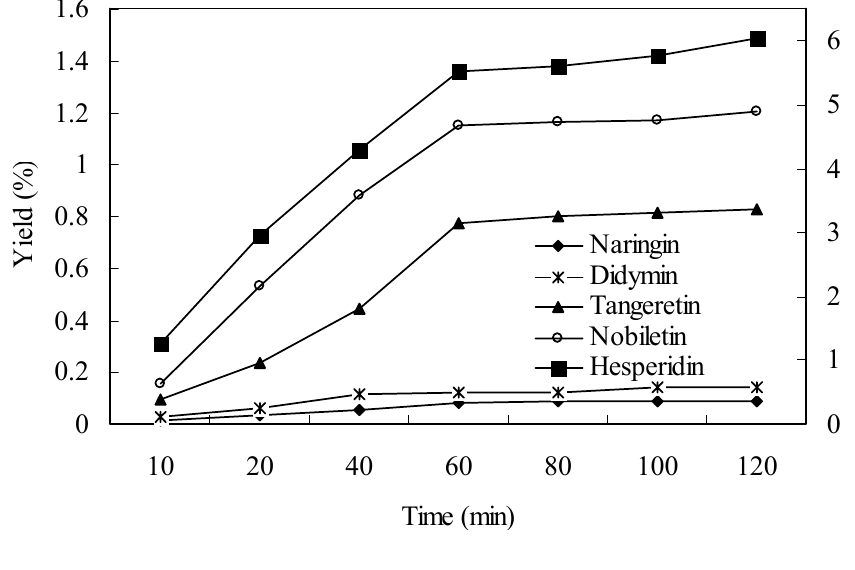
Figure 3. Effect of extraction time on the yield of naringin, hesperidin, didymin, tangeretin and nobiletin (other conditions were fixed at solvent to solid ratio = 20, temperature = 30 °C, power = 250 W).